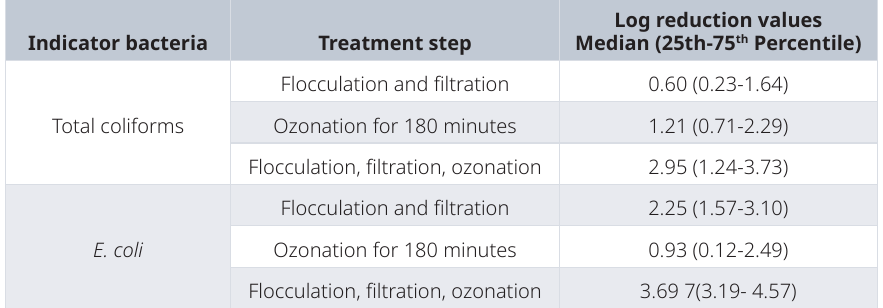
Table 2. Log removal values of E. coli and total coliforms, by treatment step. N